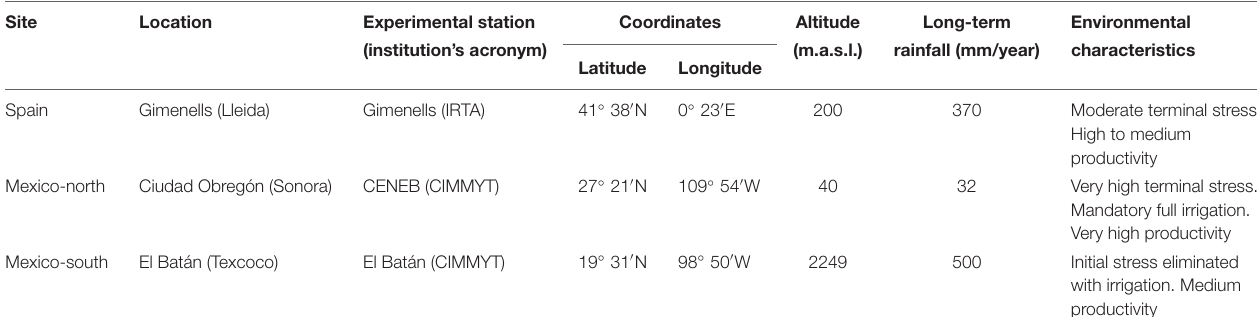
TABLE 1 | Relevant geographic and environmental descriptors for the three testing